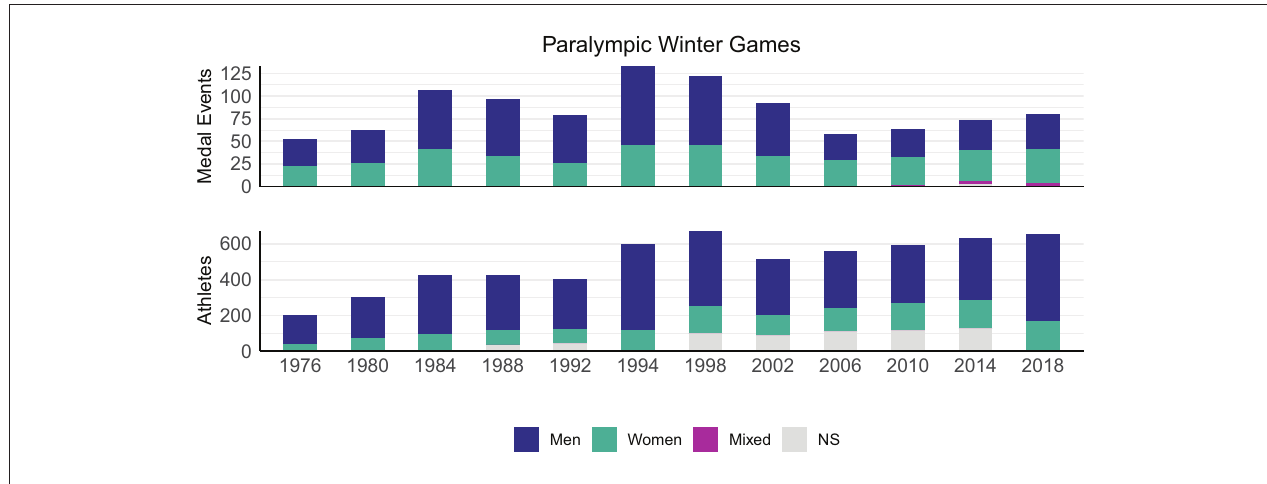
FIGURE 4 | Schematic overview showing the split between medal events for female-only, male-only, and mixed competitions, as well as the number of female and male athletes during each of the Paralympic Winter Games. Some athletes participated in more than one sport; in these cases, the number of athletes were counted once per